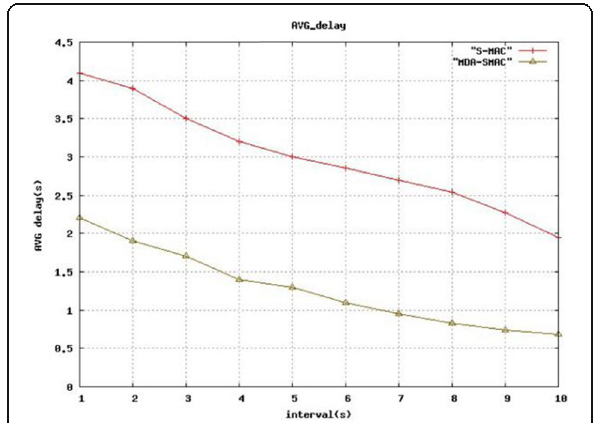
Fig. 10 The average delay of two